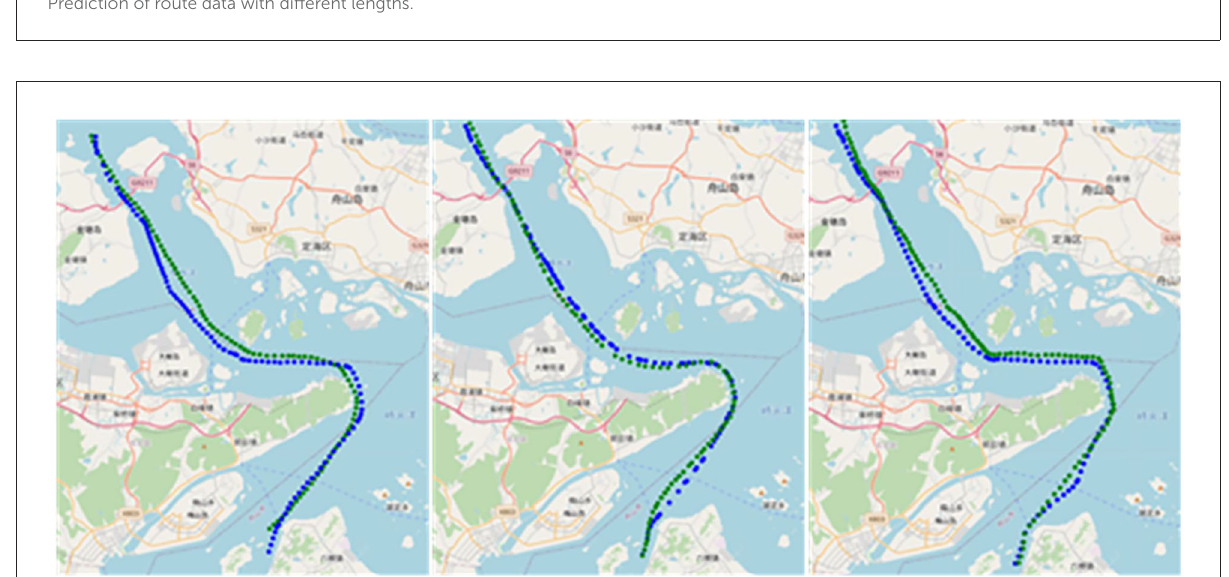
FIGURE10 Generated routes. Blue is the actual route, green is the generated routes, and from left to right, the types are cargo ships, tankers, container ships.